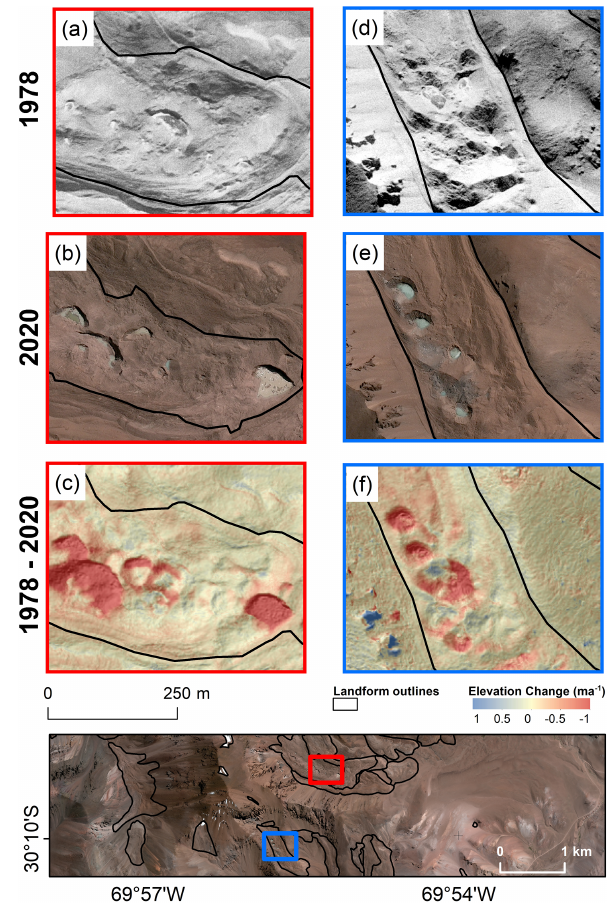
Figure 11. Comparison of orthoimagery from 1978 (aerial photog- raphy) and 2020 (Pléiades imagery) of the surfaces of the Tapado complex (red frame; a–c ) and Las Tetas (blue frame; d–f ) as well as changes in the surface elevation between 1978 and 2020. The re- spective outlines from 1978 and 2020 are shown. © CNES (2018) and Airbus DS (2018), all rights